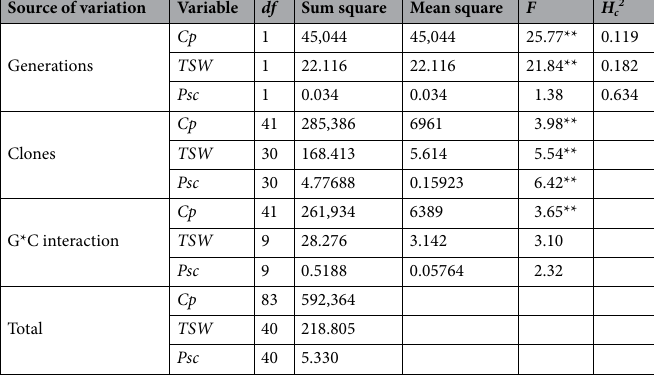
Source of variation Variable df Sum square Mean square